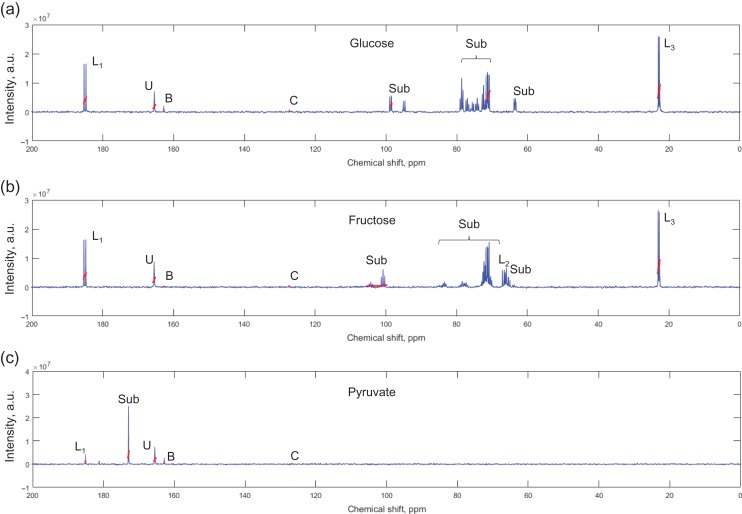
Example 13C MRS spectra for sperm incubated with: (a) 13Cu-glucose; (b) 13Cu-fructose; or (c) 13C1-pyruvate. Integral locations and widths are highlighted in red. Key: Sub – peaks from respective incubated substrate; L1, L2, L3 – lactate peaks, where the number indicates the carbon position, B – bicarbonate, C – carbon dioxide, U – urea.